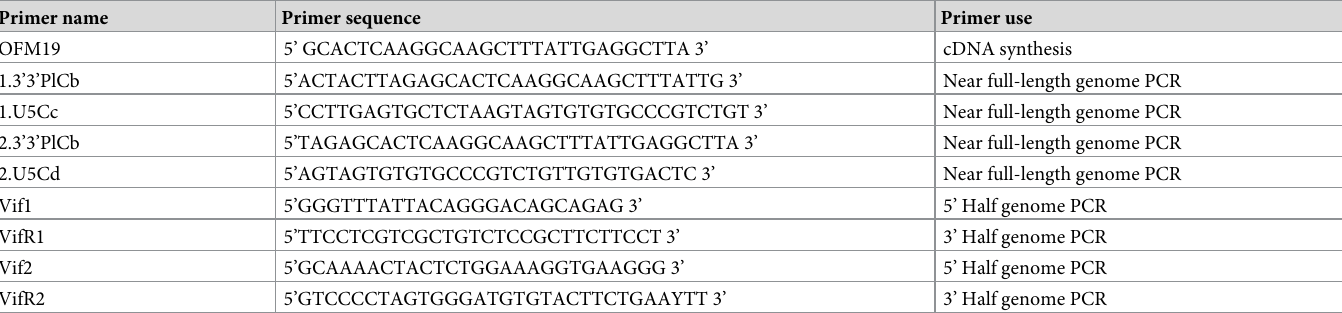
Table 1. Primers used for cDNA synthesis and single genome